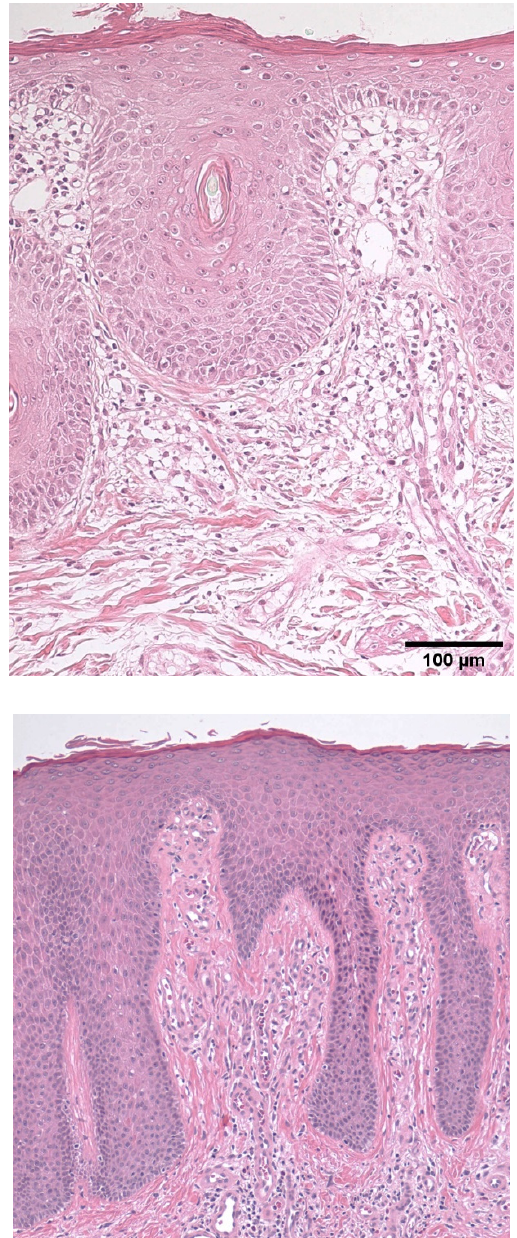
Figure 1. ( a ) Clinical images when the patient was six months old. Erythema on the whole body and scales on his head were detected. ( b ) Clinical images when the patient was five years old. Slight erythema on the whole body was still detected.